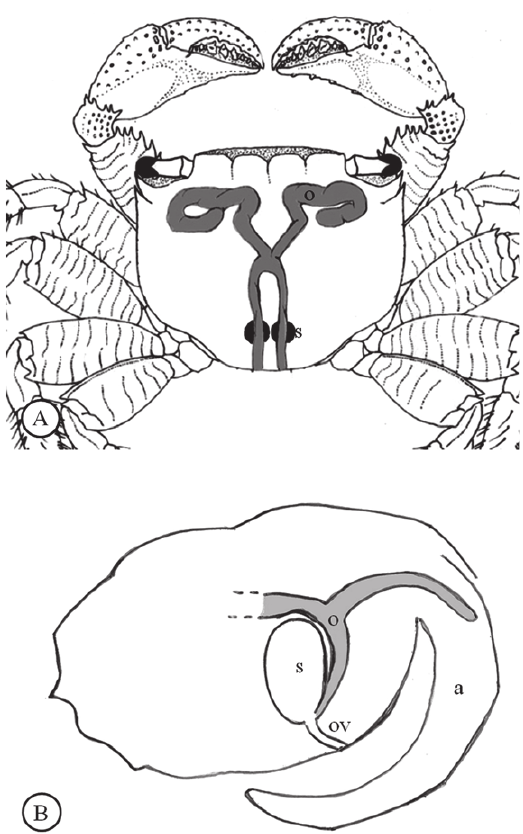
Fig . 1. – anatomy of the female reproductive system of Goniopsis cruentata. a, schematic illustration showing only of female repro- ductive system showing ovaries (o) and spermathecae (s); b, sagittal section showing ovary (o), spermatheca (s) and oviduct (ov). abdo- men Table 1. – aspects of the ovary development stages of Goniopsis cruentata . ovary (ov). Histological sections show types of germinative cells predominant in each stage (oo, oogonia; po, previtellogenic oocytes; ev, early-stage vitellogenesis; vo, late-stage vitellogenesis) and empty space (e) present in post-spawning ovaries.